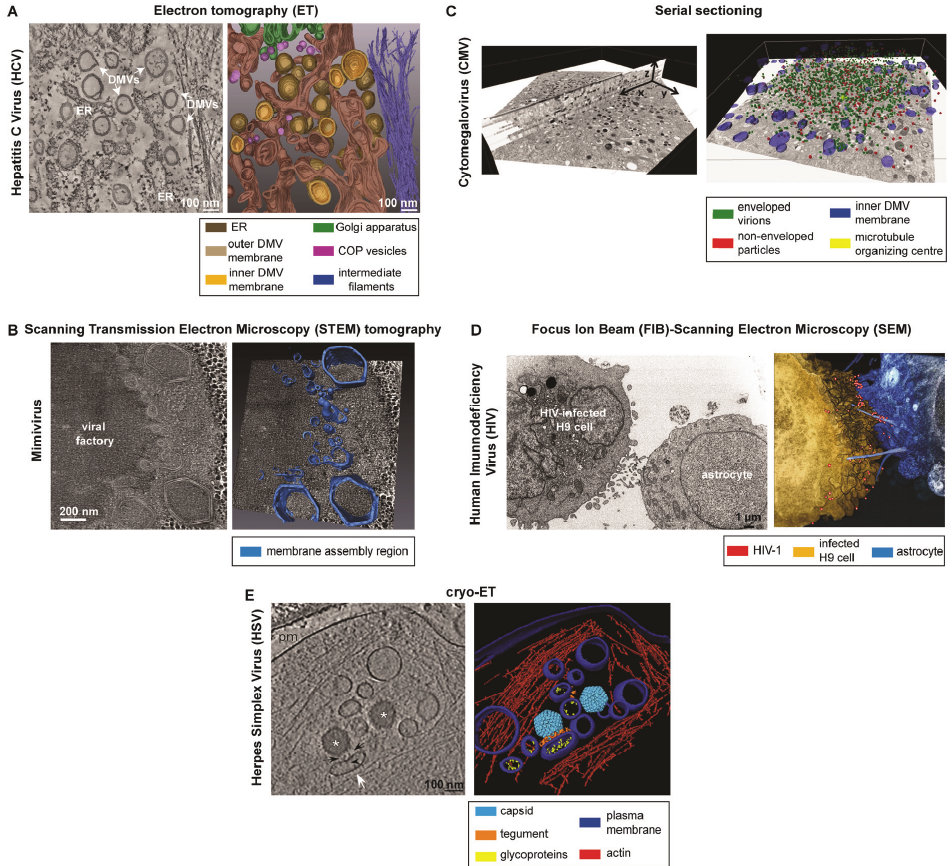
Figure 6. Examples of applications of 3D-EM methods to the study of human-relevant viral infections. ( A ) Electron tomography (ET) of Hepatitis C Virus (HCV)-infected cells [20]. On the left: slice of a tomogram showing HCV-induced double membrane vesicles (DMVs); on the right: 3D surface rendering of the whole tomogram, showing DMVs in close proximity to ER; ( B ) STEM tomography of Mimivirus-infected cells [124]. On the left: digital slice derived from STEM tomography of 280 nm thick section; on the right: 3D surface rendering revealing that the membrane assembly region consists of an elaborate membrane network; ( C ) Serial sectioning of cytomegalovirus (CMV)-infected cells [50]. On the left: single micrograph (in X–Y direction) and image stack (slice through the Z-axis) of the assembly complex; on the right: cellular and viral structures were segmented on all 28 sections and superimposed on a single micrograph; ( D ) FIB-SEM of HIV-infected cells [133]. On the left: 2D FIB-SEM image of an HIV-1 chronically infected H9 cell (left) and an uninfected astrocyte (right), co-cultured for 24 h; on the right: 3D rendering of the FIB-SEM image stack containing the contact zone between the HIV-infected H9 cell and the astrocyte. The target cell extends long filopodial bridges towards the infected cell across the intercellular gap. HIV-1 virions are detected adjacent to the filopodial bridges; ( E ) Cryo-ET of Herpes Simplex Virus (HSV)-infected cells [138]. On the left: slice of the tomogram, showing secondary envelopment of capsids; on the right: 3D surface rendering of the whole tomogram, showing a capsid in close proximity to an enveloping vesicle. Asterisks: capsids; white arrow: enveloping vesicle; arrowhead: glycoproteins; black arrows: tegument; pm: plasma membrane. All these pictures are reproduced from the original publications with permission (see Acknowledgments).